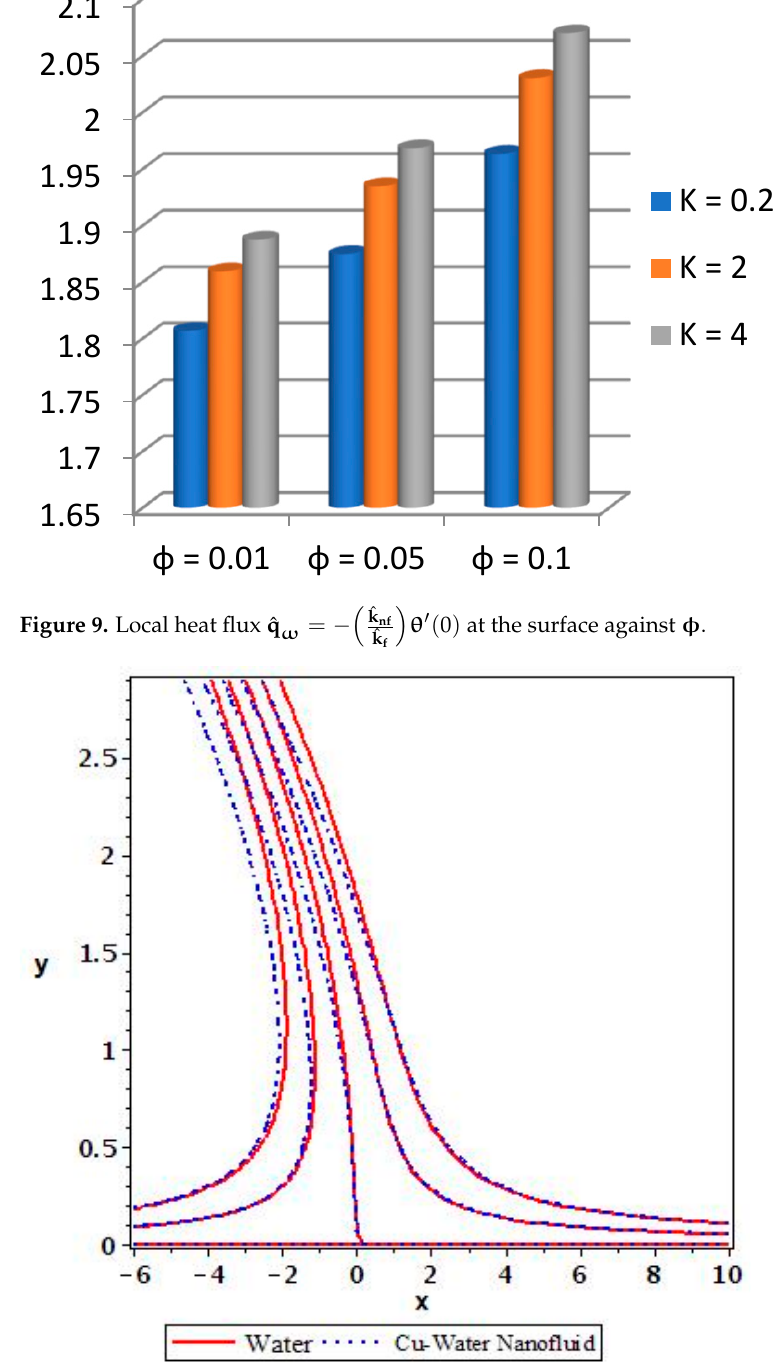
Figure 10. Streamlines for 𝛟 = 𝟎 and 𝛟 = 𝟎.𝟏 with 𝛄 = 𝟏 .